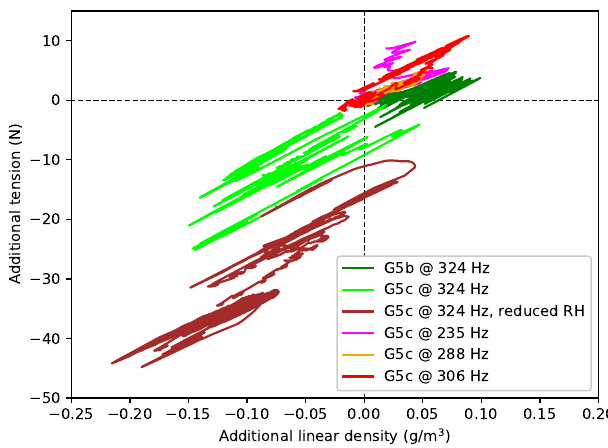
Figure 15. The additional (non-temperature related) string tension versus the additional linear density responses obtained during the extended tests with no tuning